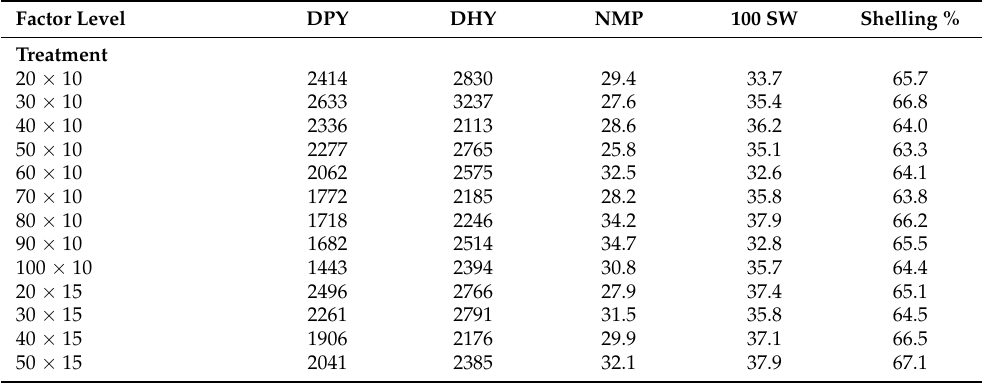
Table 7. Mean performance of spacing treatments for DPY, DHY, NMP, 100 SW, and shelling % across rainy and dry